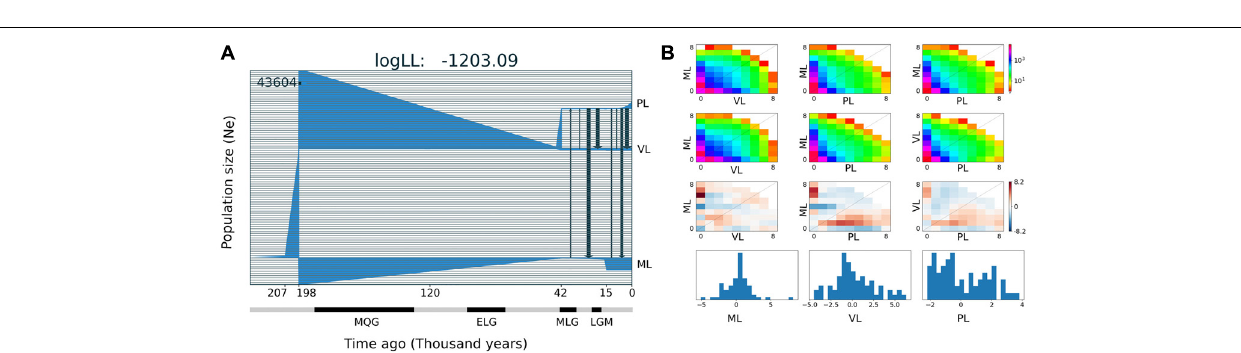
FIGURE 5 | Demographic history for three main lineages of Abrothrix hirta. (A) Demographic model of the three lineages of A. hirta : ML, Maule lineage, VL, Valdivian lineage, and PL, Patagonian lineage. The number at the top-right scales the y -axis that corresponds to effective population size. In the x-axis, time is indicated in thousands of years before present. Main glaciation events are indicated in the time axis; MQG, Middle Quaternary Glaciation, ELG, Early Late Quaternary Glaciation; MLG, Middle Late Quaternary Glaciation, LGM, Late Glacial Maximum. (B) Allele frequency spectrum distribution of sfs files (first line); theoretical model sfs (second line); residuals (third line); model adjustment for each lineage (fourth